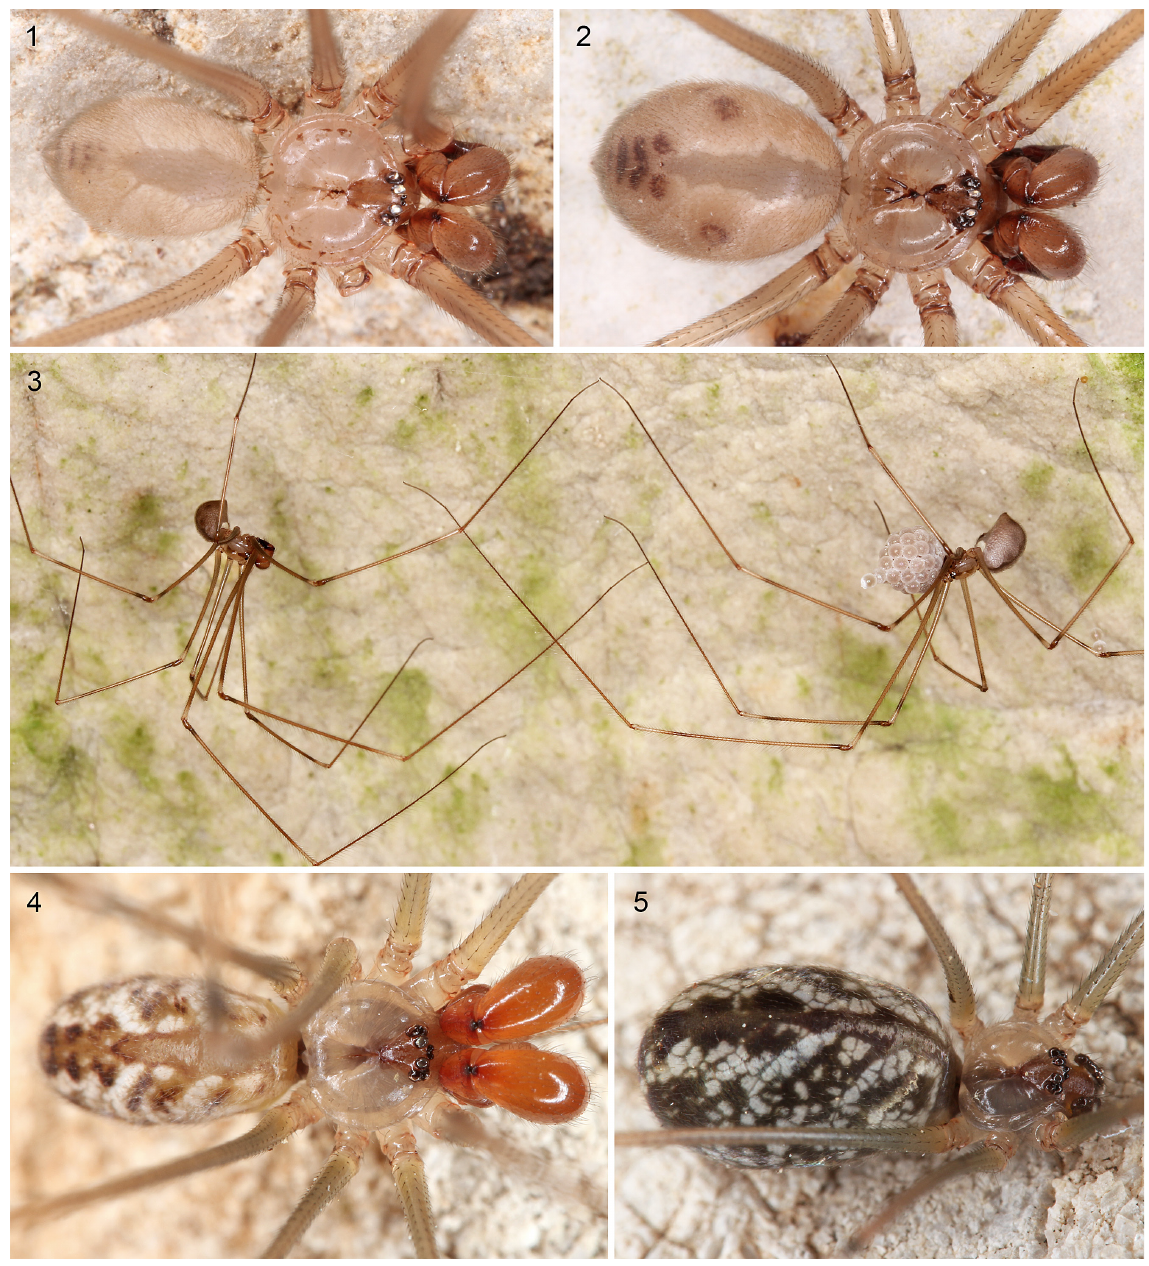
Figs 1–5. Stygopholcus Kratochvíl, 1932; live specimens. 1 . S. absoloni (Kulczyński, 1914); male from Vjetrenica, Bosnia and Herzegovina. 2 . S. skotophilus Kratochvíl, 1940; male from Pavlova pećina, Bosnia and Herzegovina. 3 . S. montenegrinus Kratochvíl, 1940; male and female with egg-sac from Studenačka pećina, Montenegro. 4–5 . S. photophilus Senglet, 1971; male and female from Episkopi, Crete. Photos: